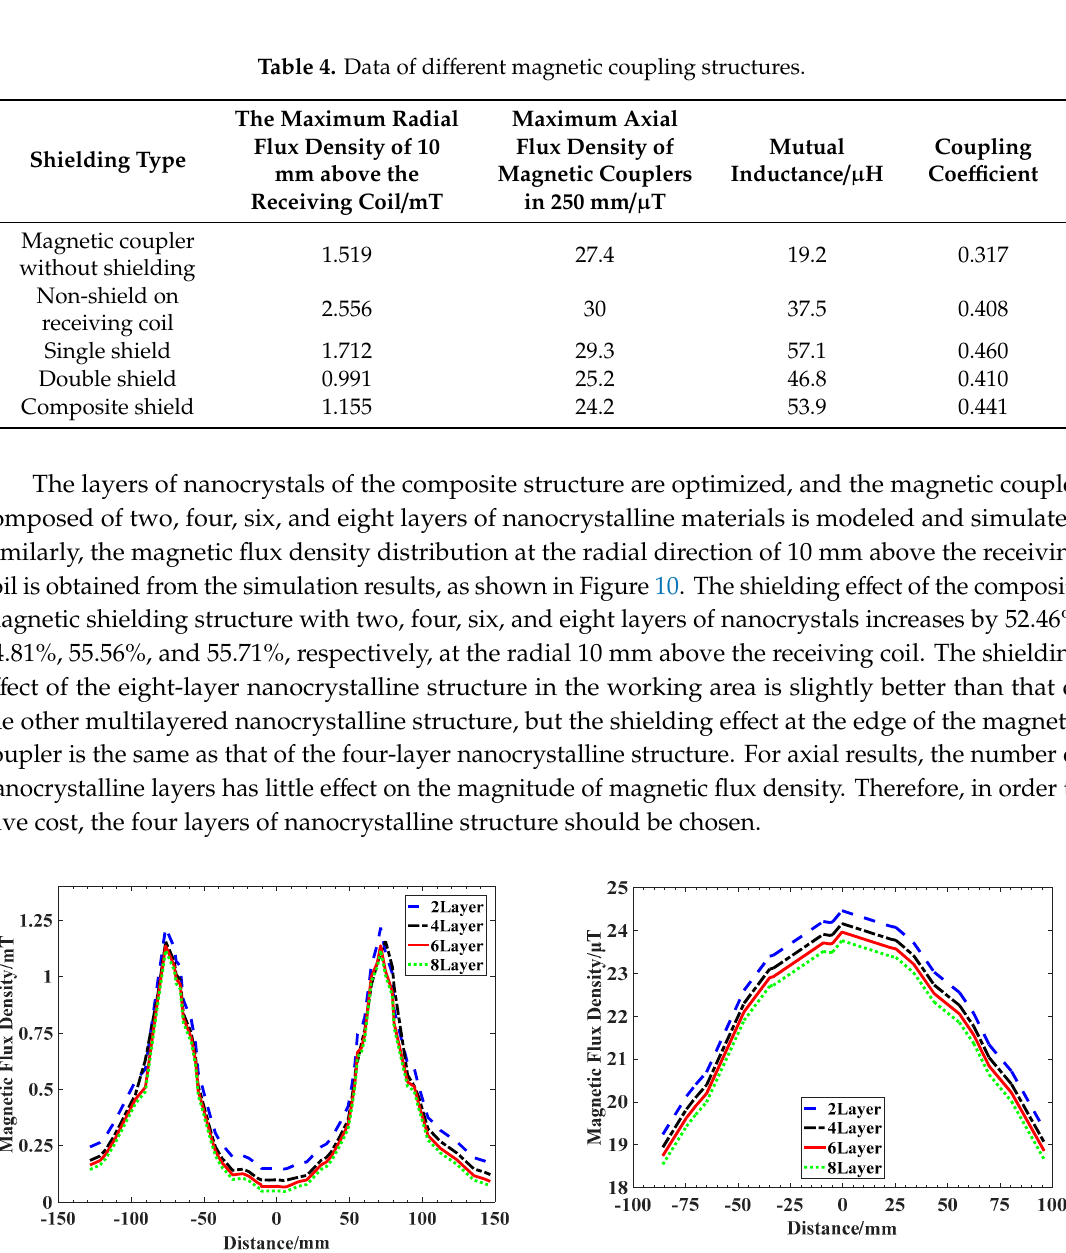
Table 4. Data of different magnetic coupling structures.